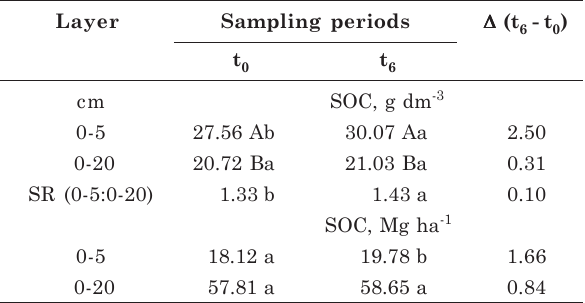
Means followed by the same capital letter in the columns and small-case letter in the lines are not different (t test, p < 0.05).